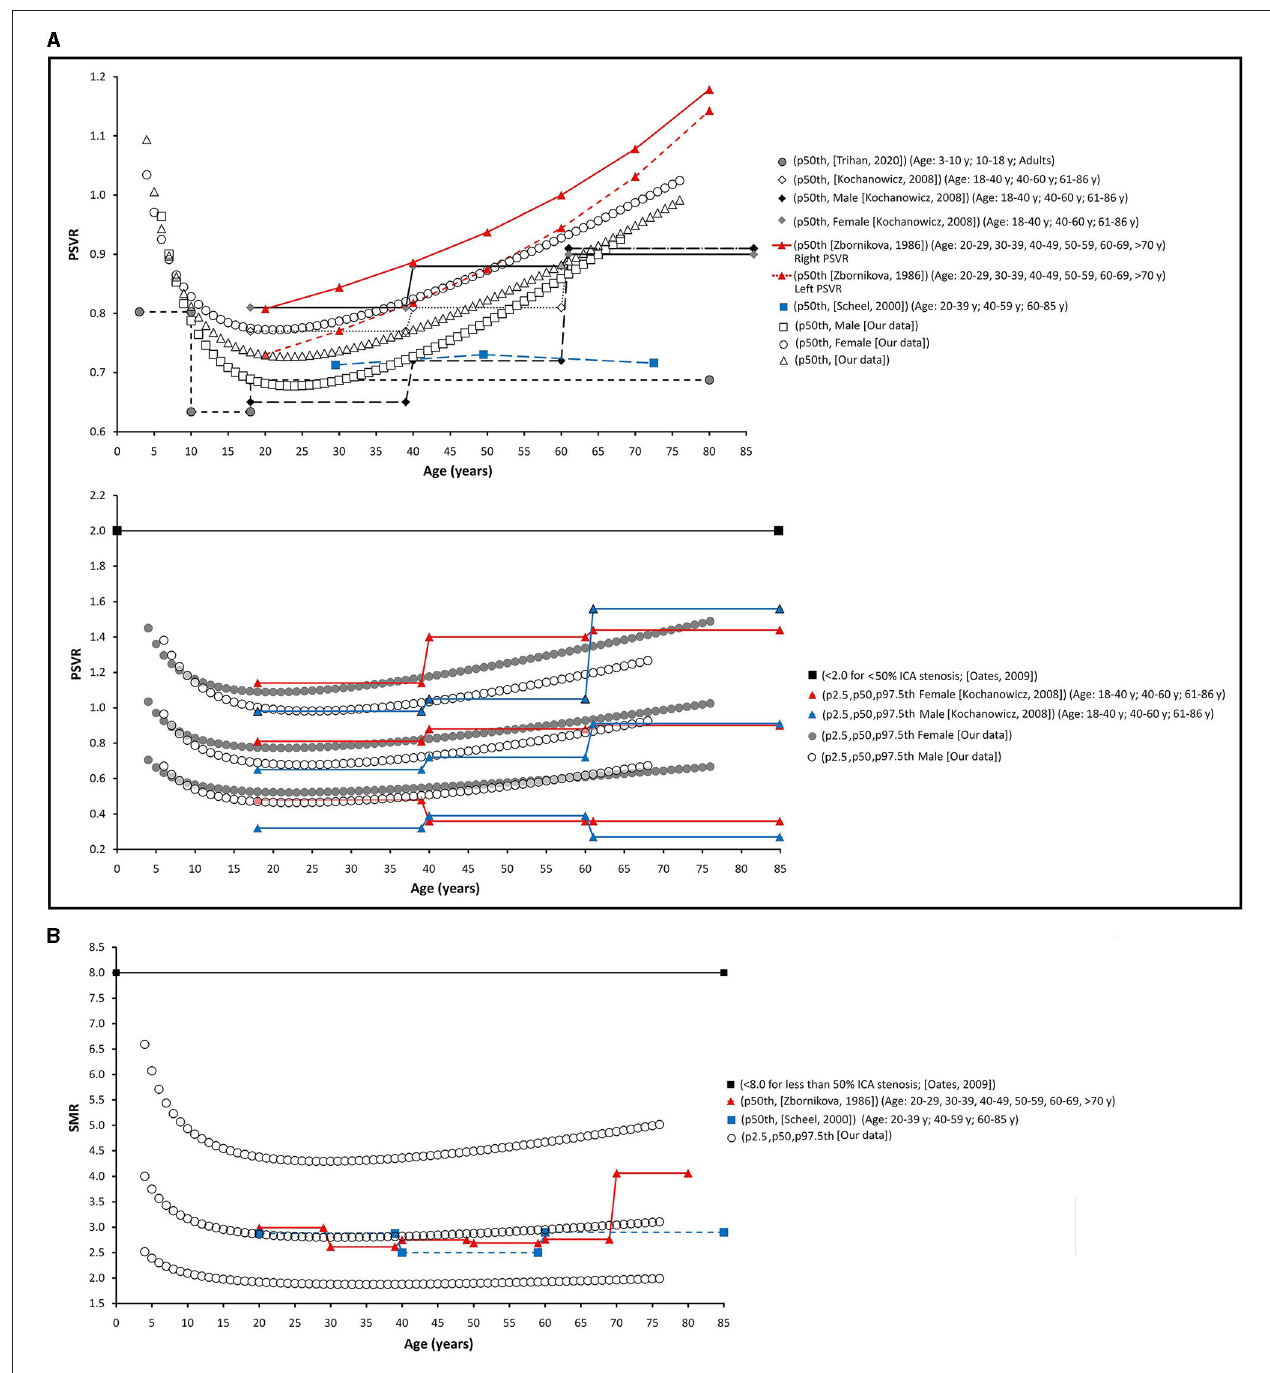
FIGURE 11 | Internal/common carotid artery velocity ratios. Comparison between curves of PSVR (A) , and SMR (B) obtained in our work (2.5th, 50th, and p97.5th percentiles) and mean values (p50th), and 2.5th (MV − 1.96 × SD) and 97.5 (MV + 1.96 × SD) percentiles obtained by other authors when studying groups of subjects of different ages. The fixed cut-off levels used to identify (graduate) levels of arterial stenosis are also shown.